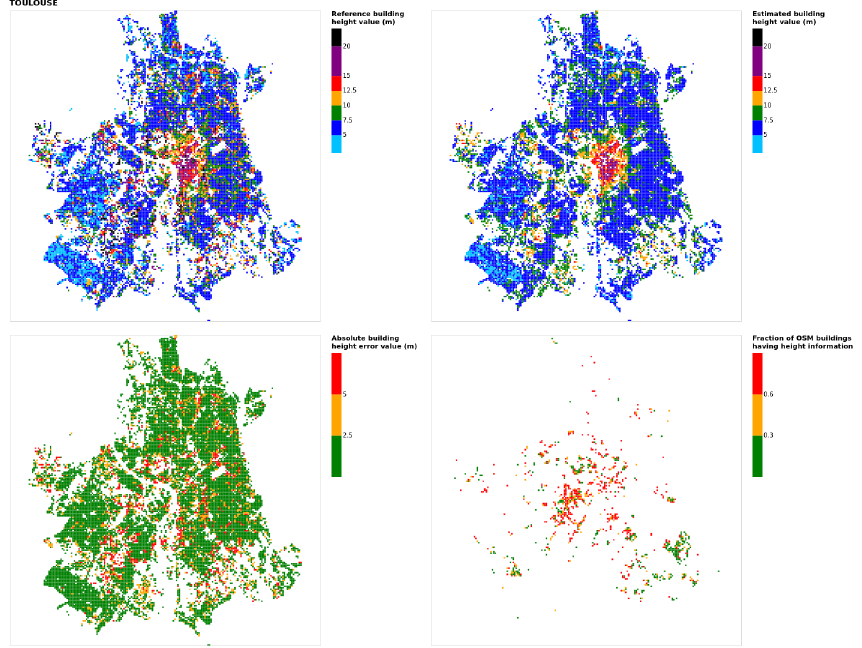
Figure B23. Results for the commune at grid cell (upper left panel) reference building height, (upper right panel) estimated building height, (lower left panel) absolute building height error, and (lower right panel) fraction of OSM buildings that have height information. For all panels except the lower right, only cells that have buildings – with at least 90% of their buildings having no height value in OSM – are